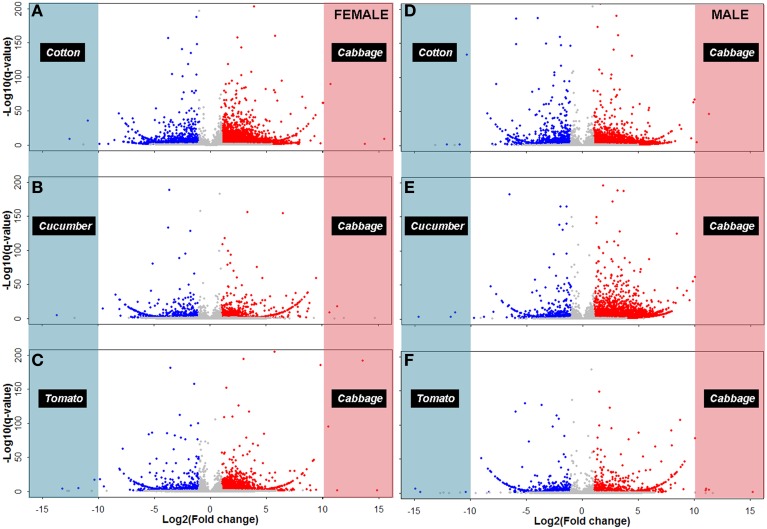
Transcriptional differences between B. tabaci adults feeding on the original and the derived hosts. The fold changes on x-axis represent the ratio of transcript abundance of B. tabaci adults on cabbage, cotton, cucumber and tomato host, respectively. Differentially expressed transcripts are highlighted in red [q < 0.05, log2 (fold change) >1] and blue [q < 0.05, log2 (fold change) < -1], respectively on the Volcano plot. (A) Cabbage female vs. cotton female; (B) Cabbage female vs. cucumber female; (C) Cabbage female vs. tomato female; (D) Cabbage male vs. cotton male; (E) Cabbage male vs. cucumber male; and (F) Cabbage male vs. tomato male.